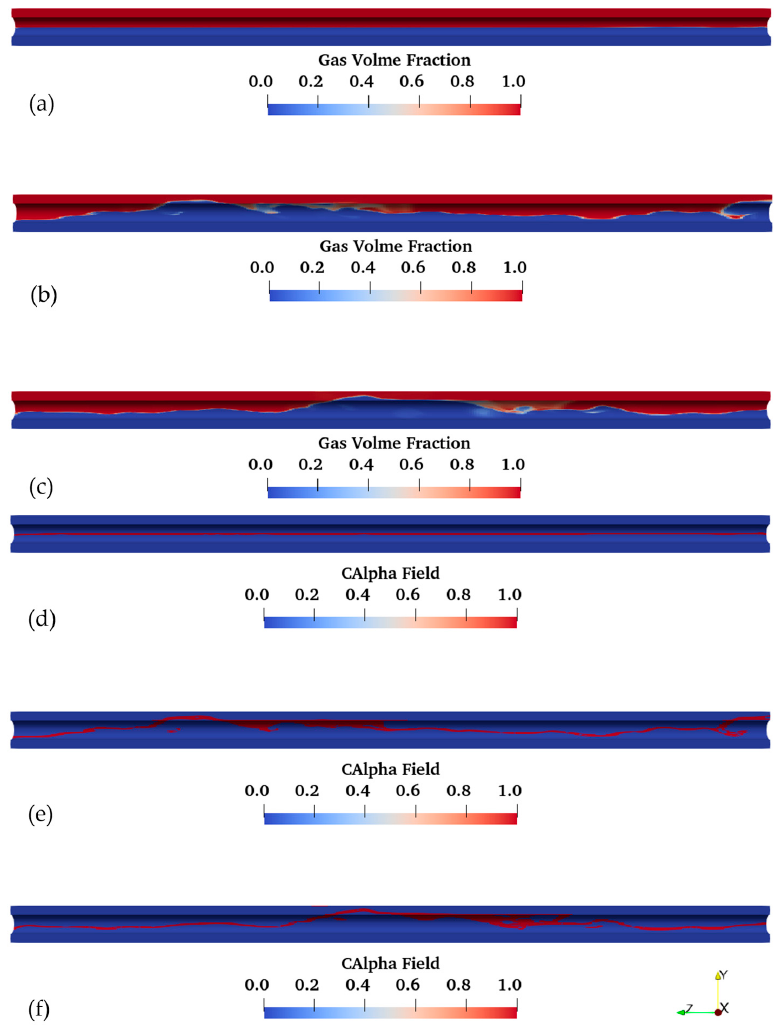
Figure 6. CFD results of the distribution of the air volume fraction ( a – c ) and C α ( d – f ) in the annular channel at times t = 0 s ( a , d ), 15 s ( b , e ) and 45 s ( c , f ). (The flow direction is from right to left.)